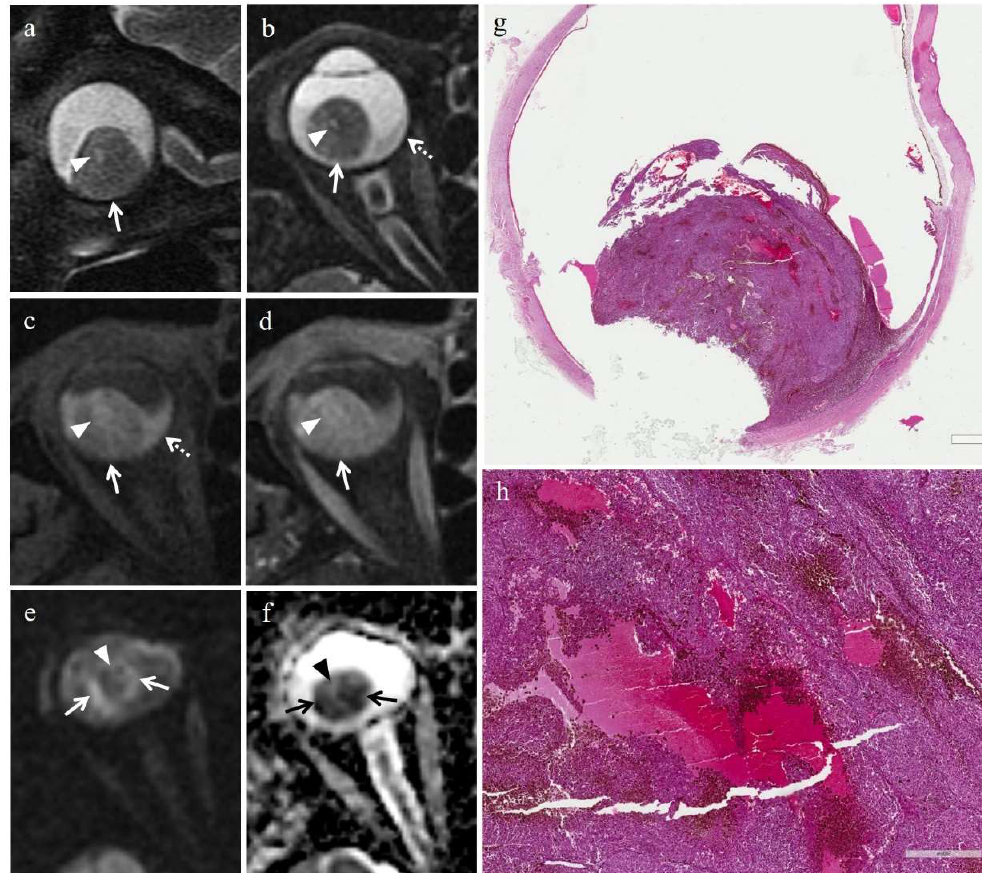
Figure 5. Hemorrhagic/coagulative-type necrosis in irradiated group (secondary enucleation). A 78-year-old female patient with a choroidal melanoma of the right eye. The patient underwent secondary enucleation 18 months after proton beam radiotherapy because of tumor regrowth. Sagittal ( a ) and axial ( b ) T2-weighted turbo spin-echo STIR images and ( c ) axial fat-suppressed T1-weighted mage display an intraocular dome-shaped mass along the postero-inferior aspect of globe (white arrows). An oval-shaped area, hyperintense on T2-weighted images and hypointense on T1-weighted image, surrounded by a thin peripheral rim, hypointense on T2-weighted and hyperintense on T1-weighted sequences (white arrowheads) is detectable within the lesion; the findings are consistent with hemorrhagic/coagulative-type necrosis. Note the hemorrhagic retinal detachment on both sides of the mass (white dotted arrow in ( b ) and ( c )), better visible on T1-weighted sequences in which it appears hyperintense because of the shortening effect of subacute blood products (methemoglobin). On ( d ) axial contrast-enhanced fat-suppressed T1-weighted image the viable neoplastic tissue of the mass enhances (white arrow); the focus of hemorrhagic/coagulative-type necrosis, without enhancement, is still recognizable (white arrowhead). On ( e ) axial DW image (b = 1000 s/mm 2 ) and ( f ) corresponding ADC map the viable neoplastic tissue shows restricted diffusion with high signal intensity on DWI image (white arrows) and low signal intensity on ADC map (black arrows); the necrotic focus does not exhibit restricted diffusion and is hypointense on DWI image (white arrowhead) and slightly hyperintense on ADC map (black arrowhead). ( g ) On low magnification (H&E, original magnification 25 × ), histological examination shows a largely viable and poorly pig- mented residual tumor mass, located at the posterior segment of the eye, that contains multiple intratumoral foci of intratumoral hemorrhagic/coagulative-type necrosis. ( h ) Higher magnification (H&E, original magnification 150 × ). Although the case is from a secondary enucleation, necrotic foci exhibit abundant fibrin deposition, hemorrhagic infarction and are rimmed by heavily-pigmented extravasated melanophages. Note the striking consistency between the histologic and MR findings with reference to the necrotic